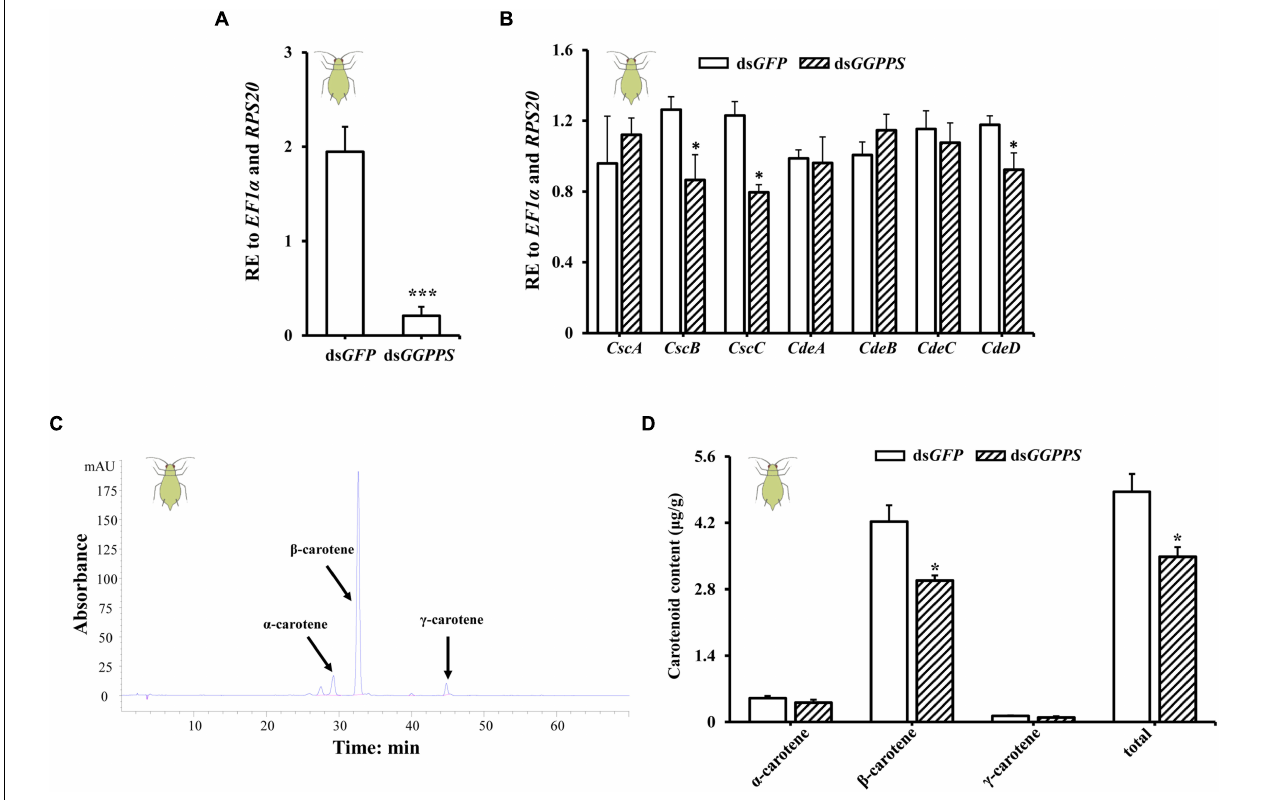
FIGURE 3 | Expression patterns of GGPPS , carotenoid biosynthesis-related genes, and carotenoids content upon silencing of GGPPS in the green morph of Acyrthosiphon pisum . (A) RNAi efficiency of GGPPS . (B) Expression patterns of carotenoid biosynthesis-related genes after RNAi of GGPPS . (C) The prominent peak retention time of green morph by HPLC. Black arrows represent different carotenoids. (D) Carotenoid content of the green morph after silencing of GGPPS . Significant differences between ds GFP and ds GGPPS are indicated by asterisks ( ∗ P < 0.05; ∗∗∗ P <